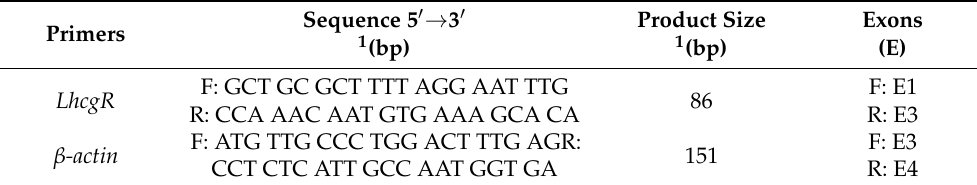
Table 2. Sequences and exonic localization of the oligonucleotides primers of LhcgR and β -actin used for real-time polymerase chain reaction (PCR) analysis on partial sequence of Meriones libycus cDNA LhcgR